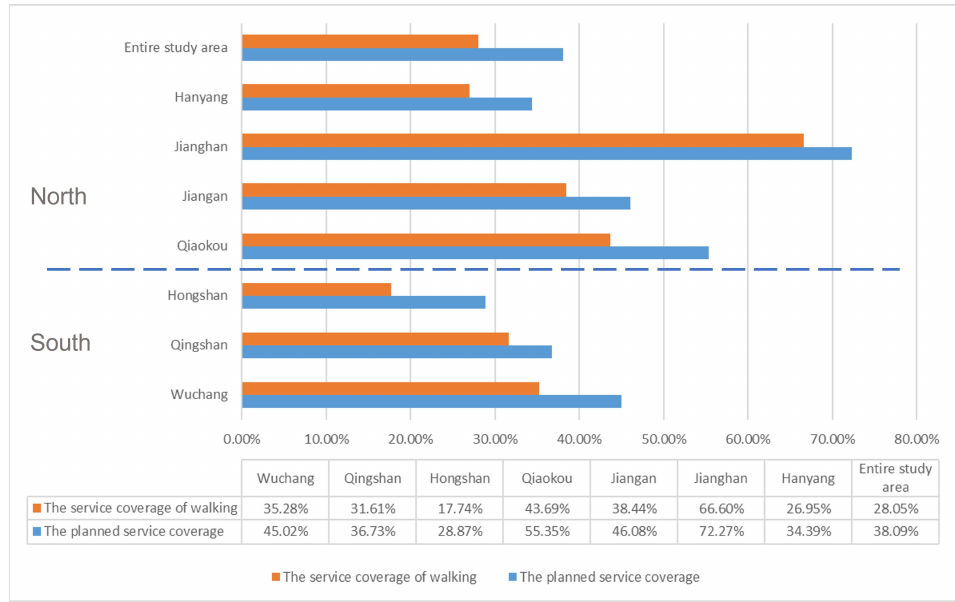
Figure 7. Planned service areas for chronic disease pharmacies vs. actual service areas based on walking.